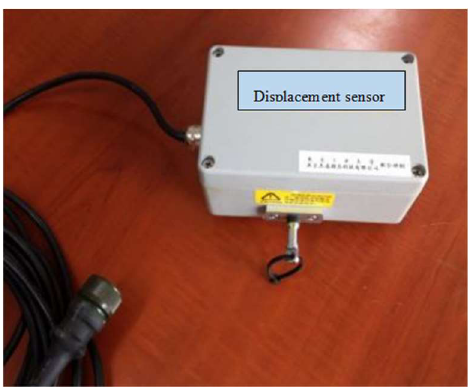
Table 1. High-precision and large-range cable displacement sensor parameter.